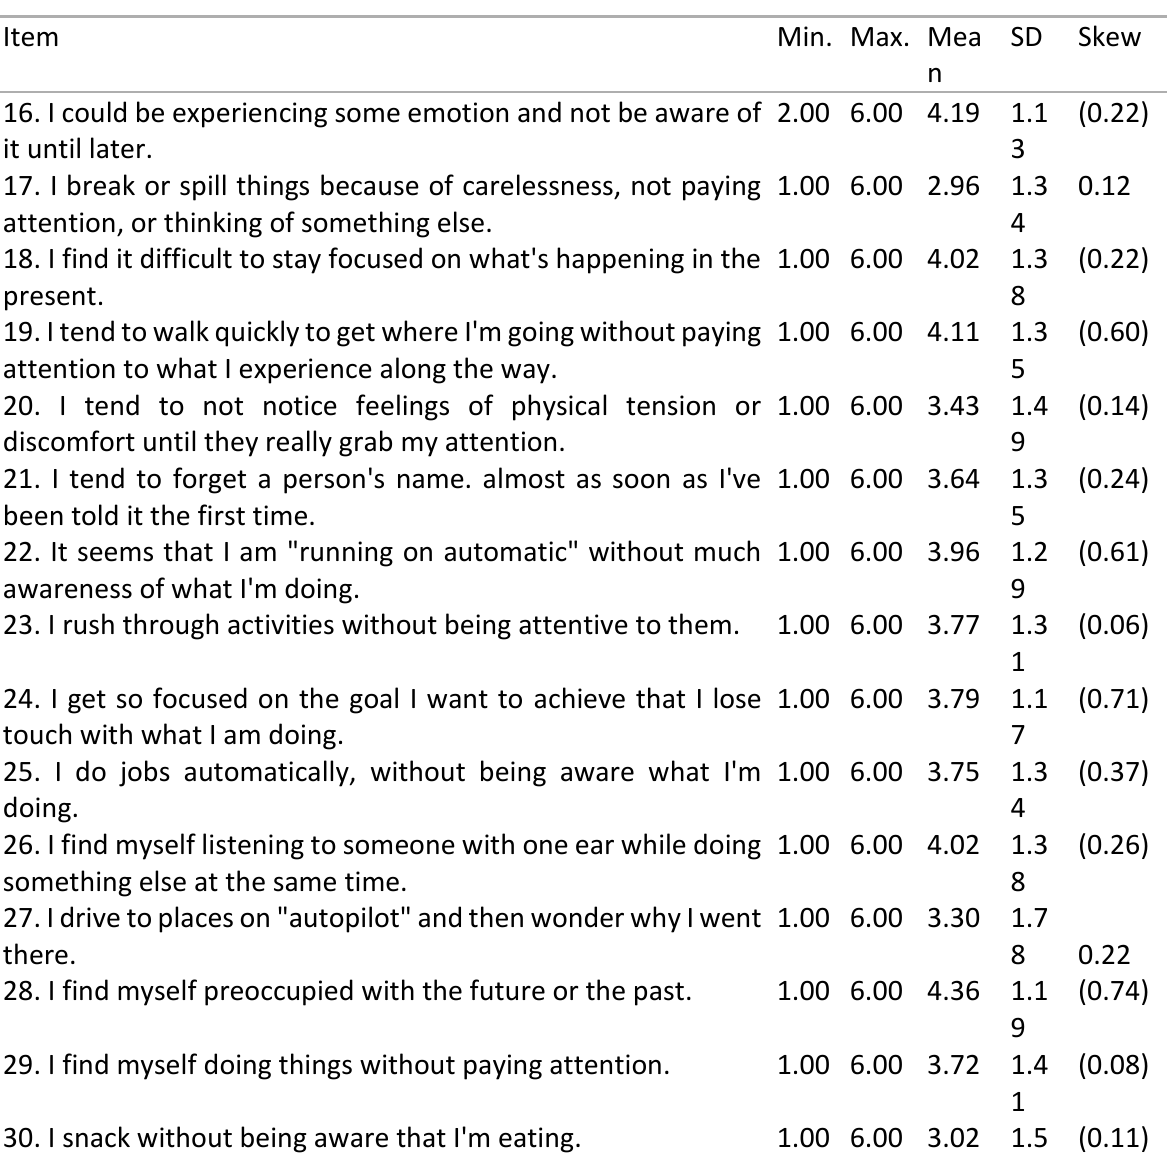
Table 2. Descriptive Statistics associated with Mindfulness Items (n =